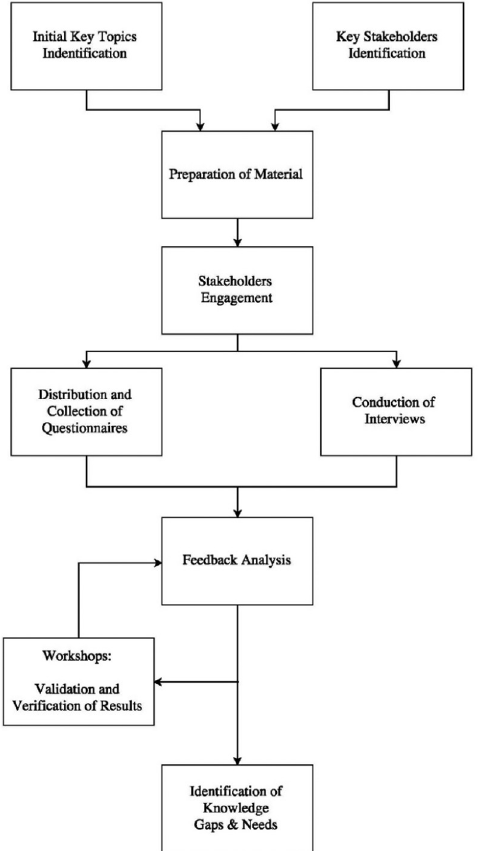
Figure 1. Stages of the proposed methodology for identi fi cation of knowledge gaps and